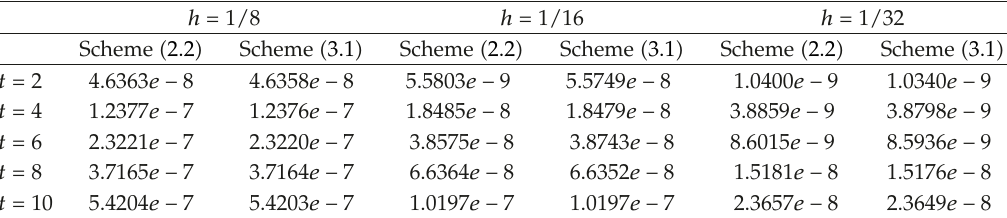
Table 2: The errors estimates in the sense of (cid:4) · (cid:4) ∞ , when p (cid:7) 4 and τ (cid:7) 0 .